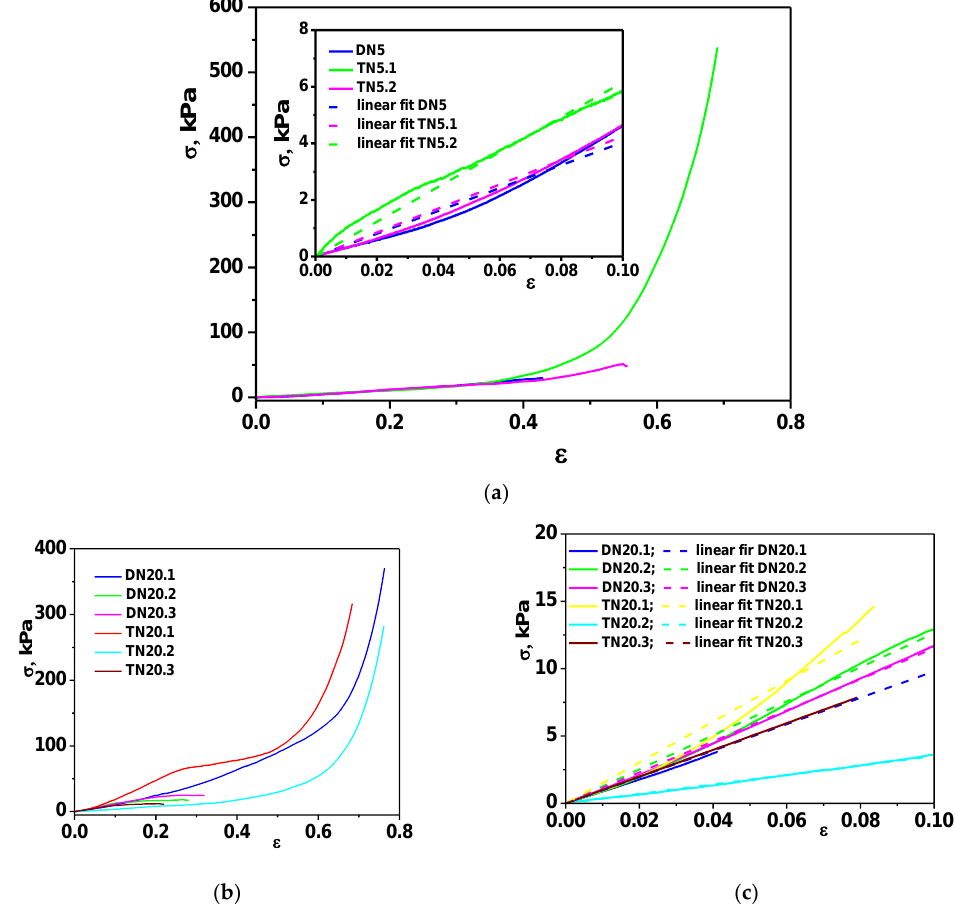
Figure 4. The mechanical properties of DN and TN network cryogels. Stress – strain profiles of DN and TN obtained starting from SN5 ( a ) and SN20 ( b ) cryogels (the inset of ( a ) presents the linear dependence of stress – strain curves used for the calculation of compression elastic moduli of DN5 and TN5 cryogels). ( c ) Linear dependence of stress – strain curves from which the compression elastic moduli of the DN20 and TN20 cryogels were determined. Table 2. Compressive elastic modulus, compressive nominal stress and maximum strain of the DN and TN composite